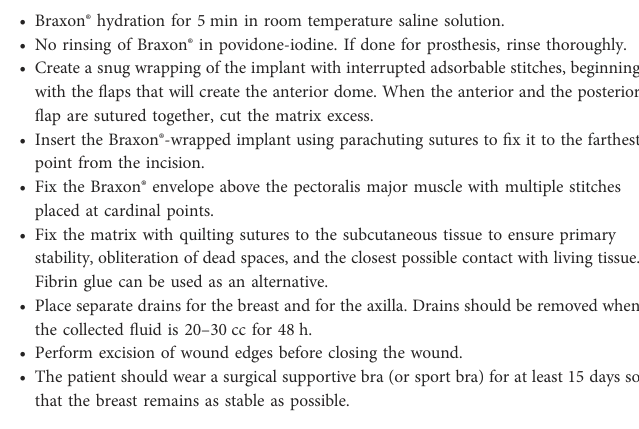
TABLE 1 Braxon® surgical steps. Mastectomy